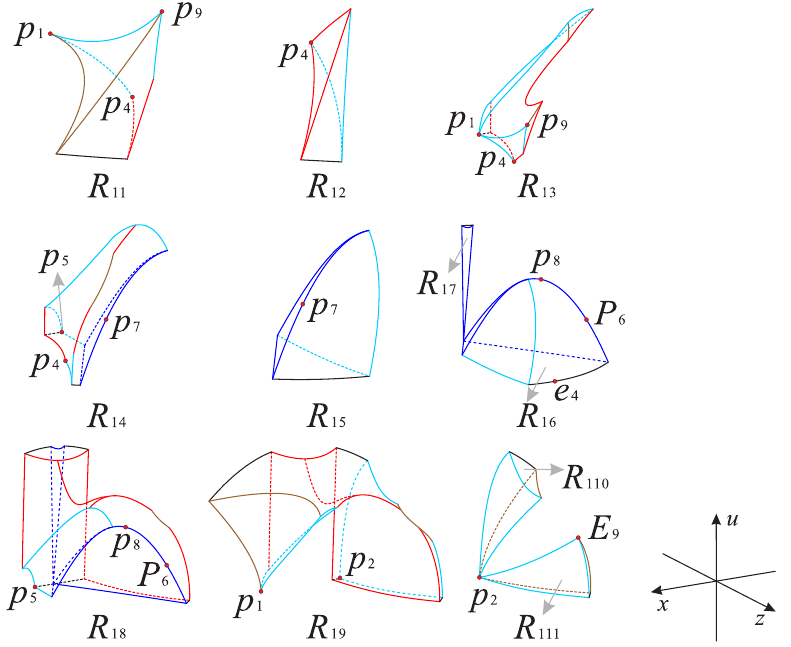
Figure 21. There are the eleven subregions inside the region R 1 of the Poincaré